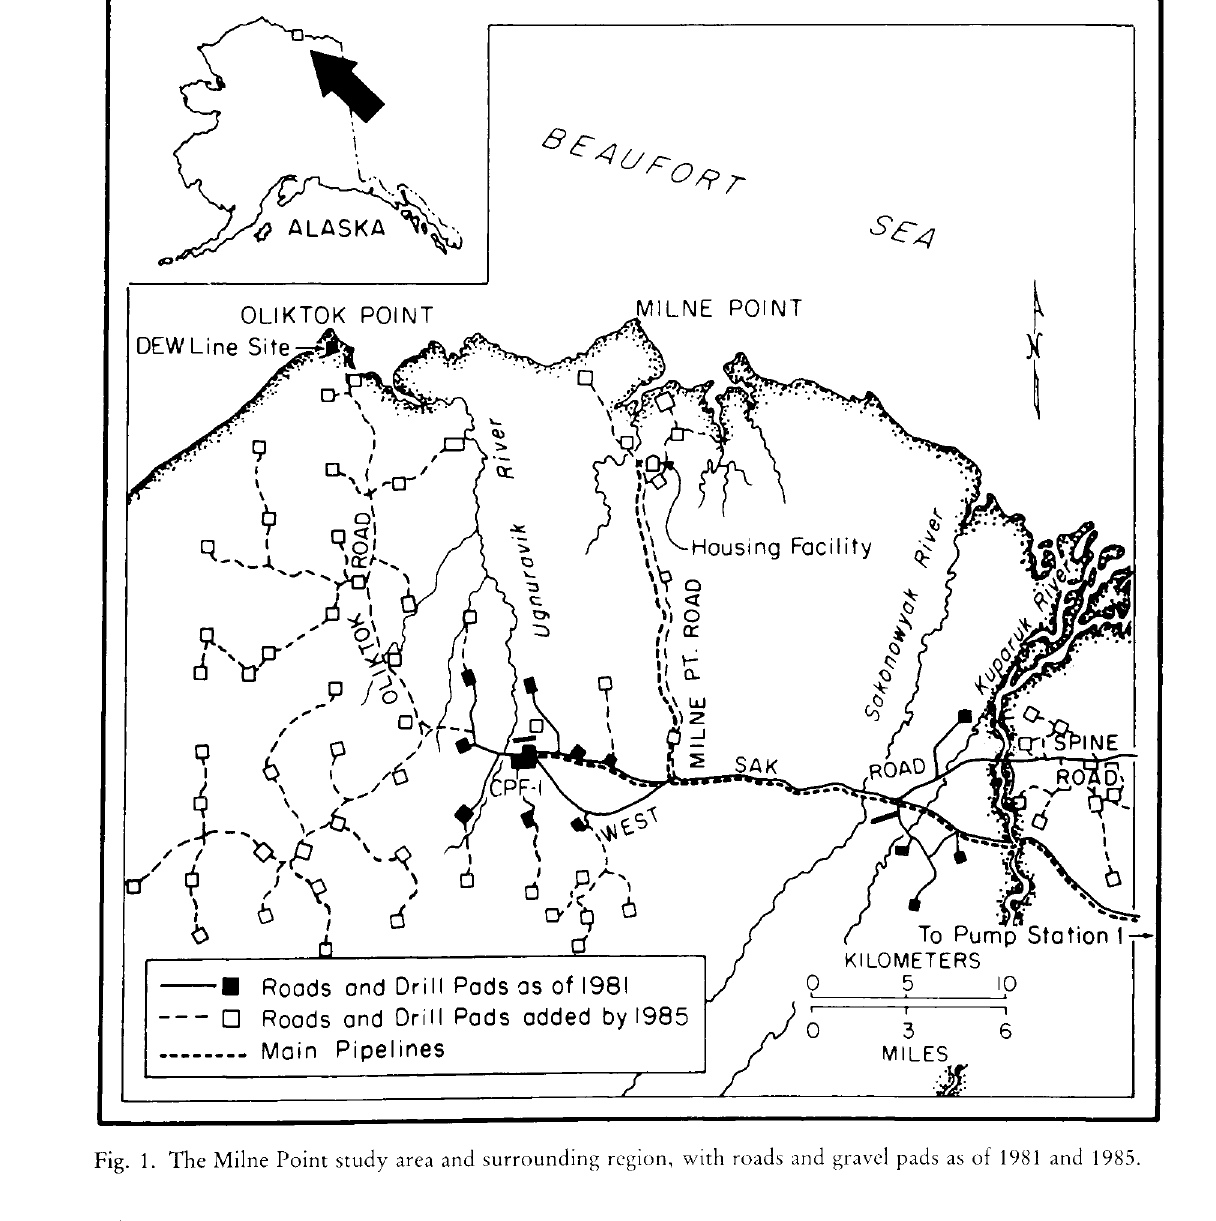
Fig. 1. The Milne Point study area and surrounding region, with roads and gravel pads as of 1981 and 1985. (Fig. 1). Terrain ranges from sea level to 25